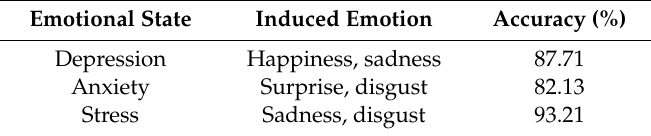
Table 4. Correlations between emotions and DASS levels.